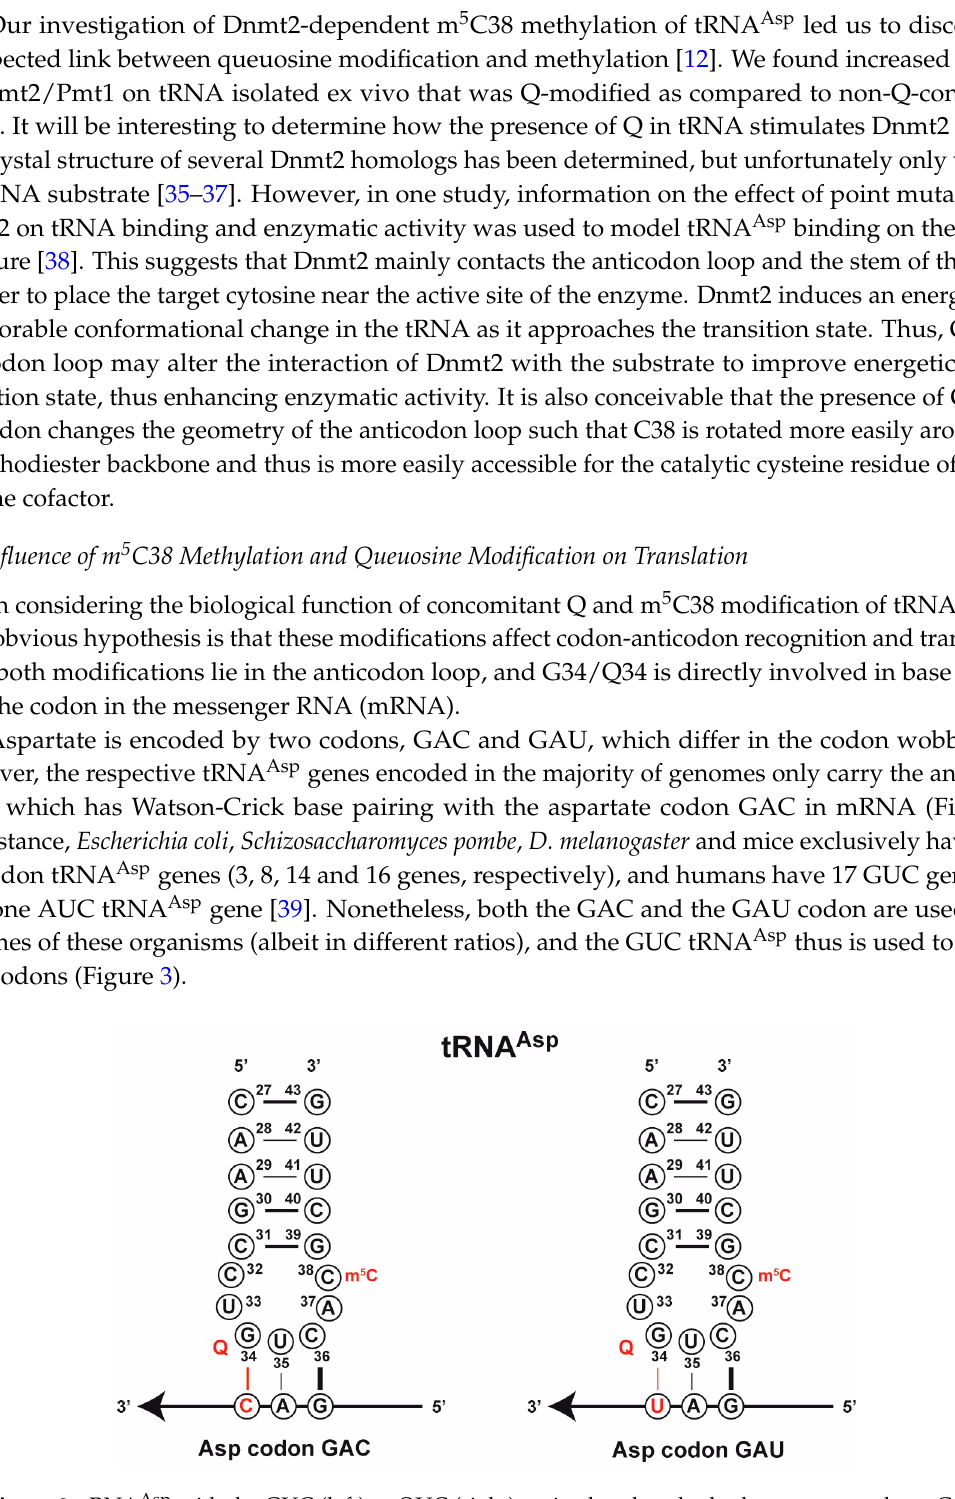
Figure 2. tRNA Asp with the GUC (left) or QUC (right) anticodon decodes both aspartate codons, GAC (left) and GAU (right). The sequence of the anticodon stem ‐ loop of tRNA Asp from S. pombe is given.